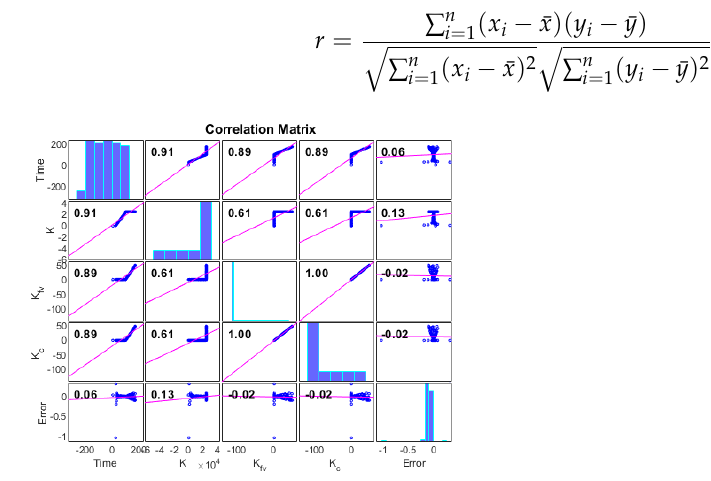
Figure 11. Pearson correlation chart between the parameters and